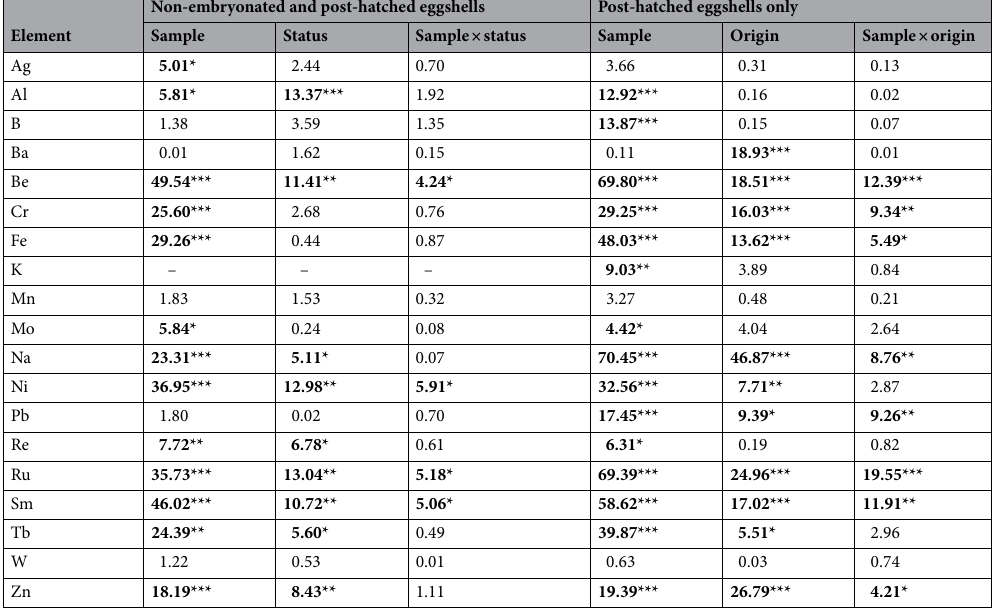
Table 3. F -values and the accompanying significance levels of two-way ANOVAs performed to test the effect of sample (= eggshell region—background vs. spot), egg status (non-embryonated eggs vs. post-hatched eggshells) and origin of eggs (from wild vs. captive birds) on ICP-OES-based eggshell elemental profiles in Capercaillie Tetrao urogallus . Statistically significant effects are in bold. Since the post-hatched eggshells were obtained from only captive birds, we ran two separate ANOVAs to test (1) the effect of sample and egg status over non-embryonated and post-hatched eggshells, and (2) the effect of sample and origin within the post- hatched eggshells only. The elemental concentrations corresponding to the tested effects are listed in Table S4. * P < 0.05; ** P < 0.01; *** P <